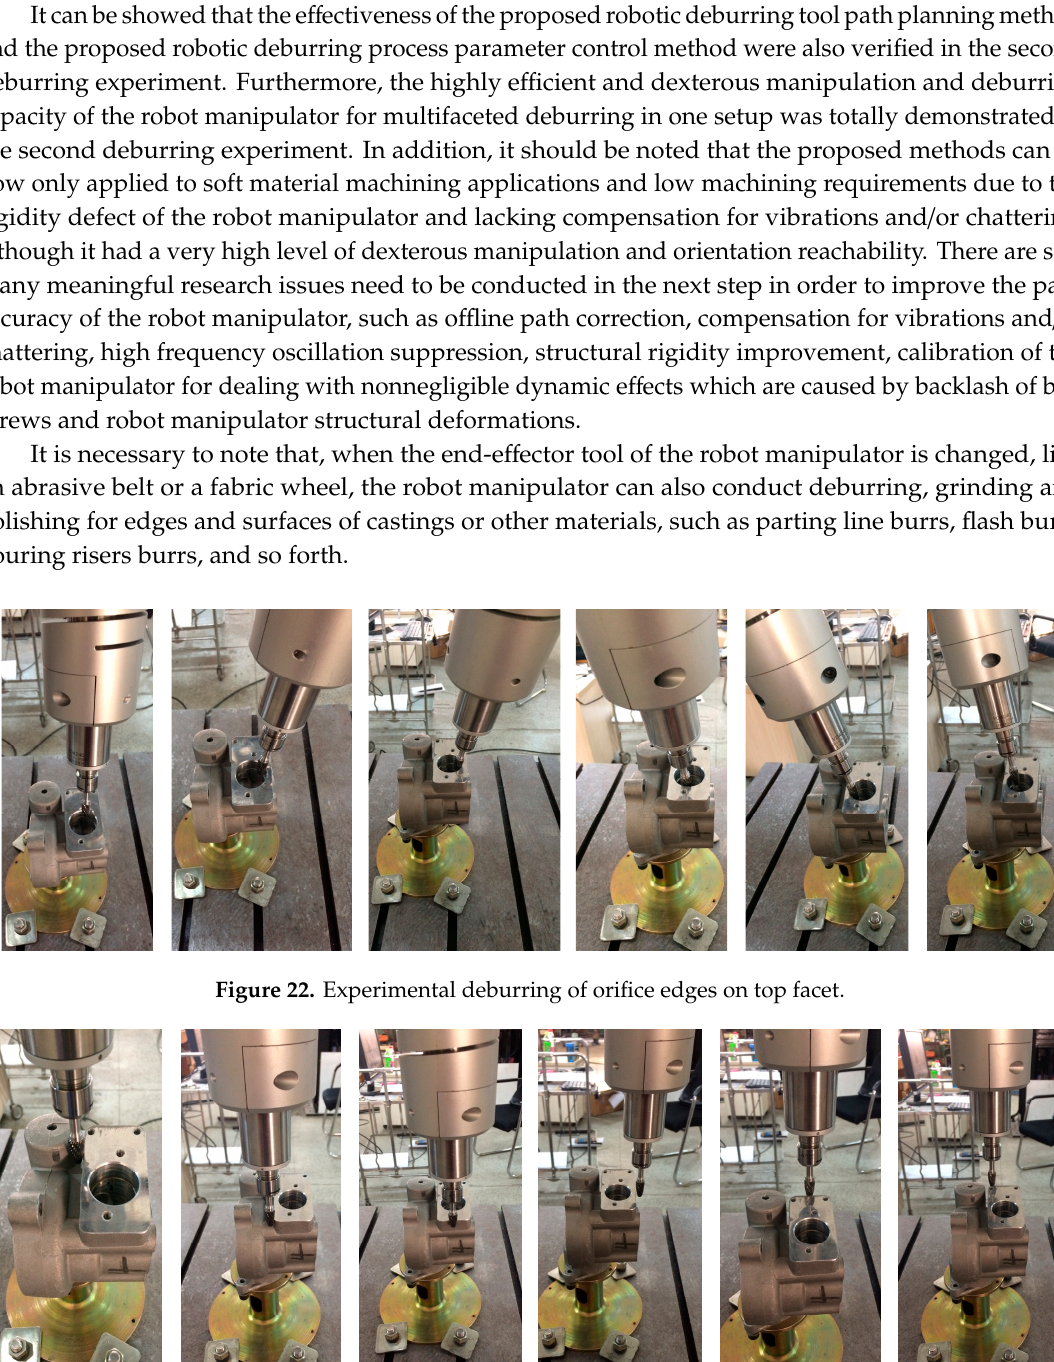
Figure 24. Experimental deburring of orifice edges on distal side facet. Figure 25. Experimental deburring of facet edges on distal side facet.